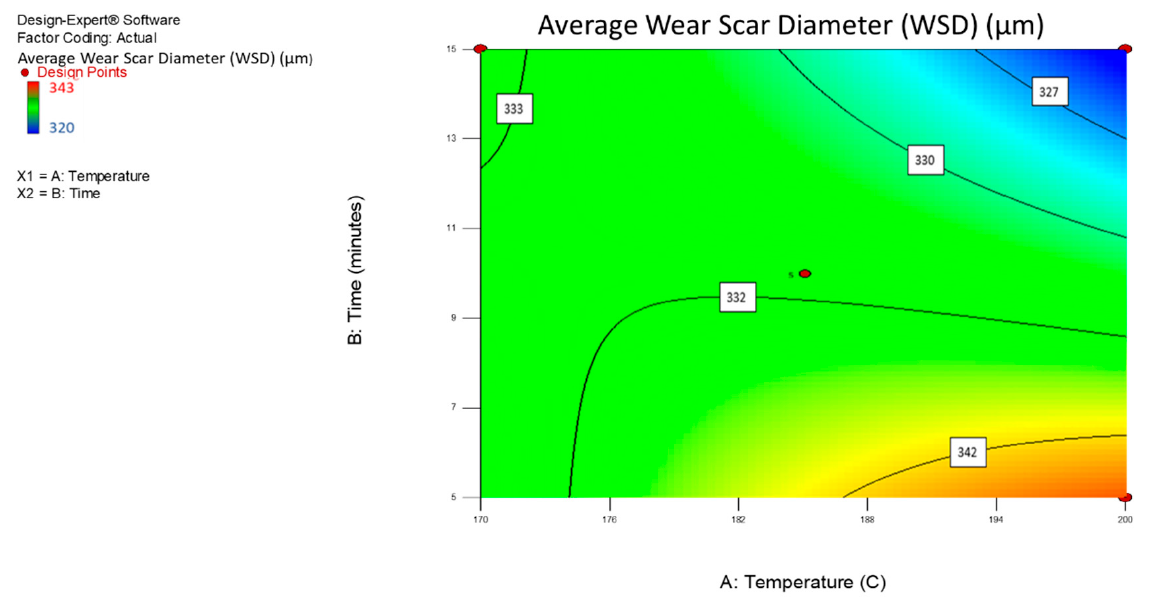
Figure 10. A contour interaction plot of the average WSD for the MoS 2 nanolubricants. Figure 11 represents a plot for the residual vs. the predicted values typically used to define or validate the presumption of constant variance. The graph showed a strong constant variance, and the values were well-spaced and randomly distributed along the line outcomes; therefore, the model correctly matched the variances. Figure 12 displays the residual versus run map, where the values were uniformly distributed, and most of the values were within the positive range. There were no outliers and extreme points in